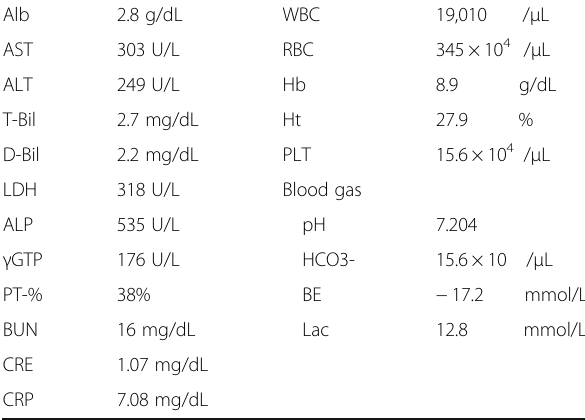
pancreaticoduodenal Table 1 Clinical laboratory data on hospital